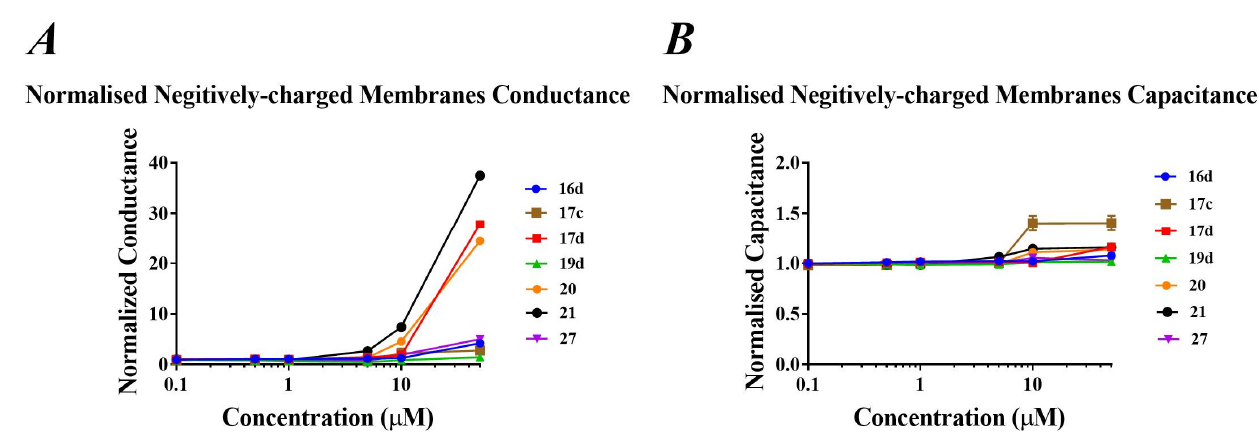
Figure 4. ( A ) Changes in membrane conduction and ( B ) changes in membrane capacitance in negative-charged tBLMs, in response to increasing concentrations of compounds 16d, 17c, 17d, 19d, 20, 21 and 27 .